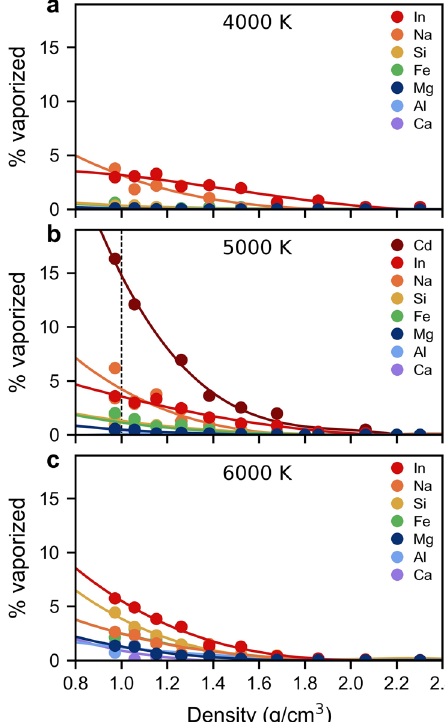
Fig. 1 Volatility as a function of density and temperature. The proportion of elements existing in the vapor phase in In 3 + -bearing pyrolite at a 4000 K, b 5000 K, and c 6000 K. The calculated volatilities for Cd 2 + - bearing pyrolite are shown at 5000 K as well. A single polynomial was fi tted to each element type (averaged for the two compositions at 5000K) as guide for the eyes to show the increasing vaporization trend with decreasing density. A dashed vertical line at 5000 K shows the conditions explored in Fig.